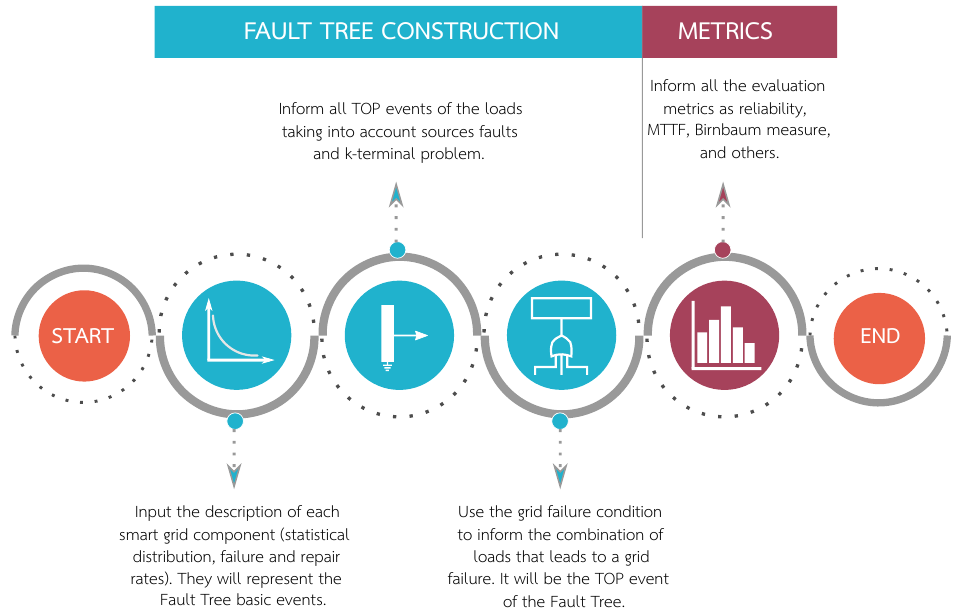
Figure 6. Fault Tree construction and evaluation